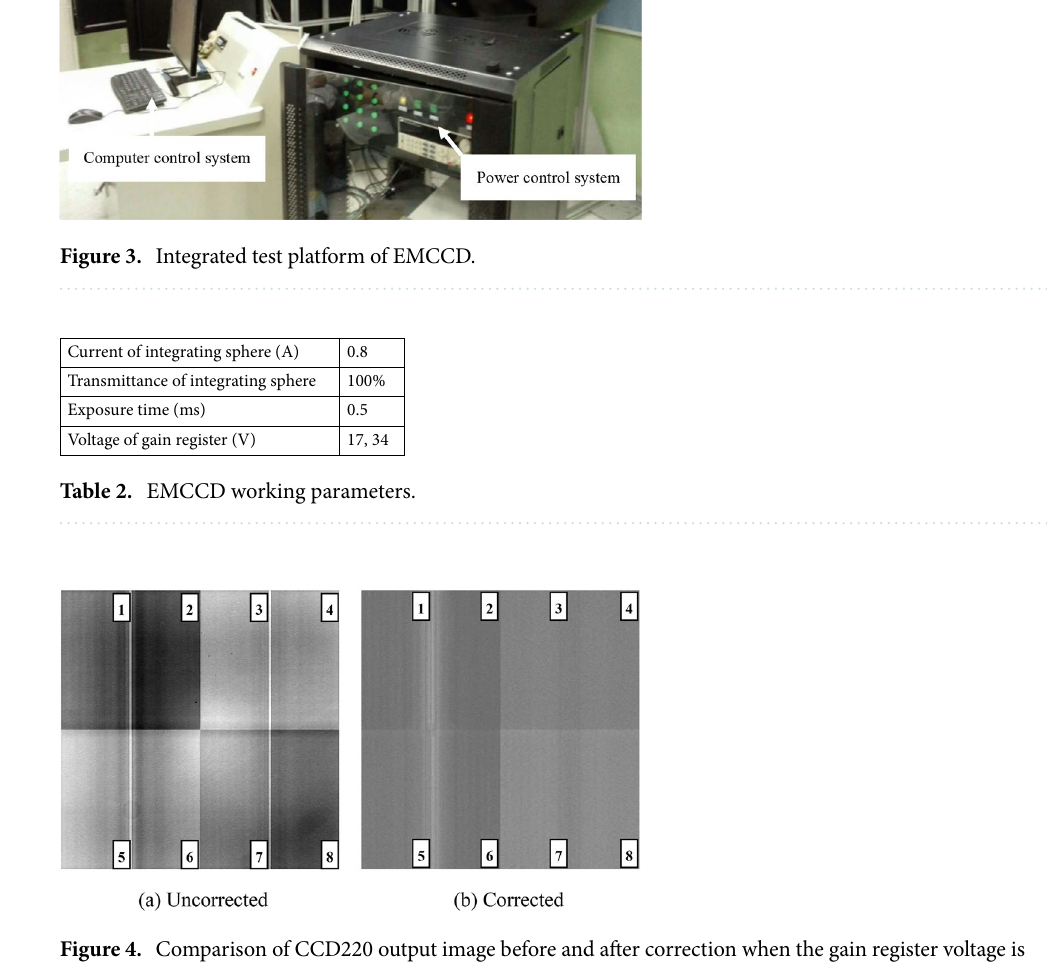
Figure 4. Comparison of CCD220 output image before and after correction when the gain register voltage is 17 V.